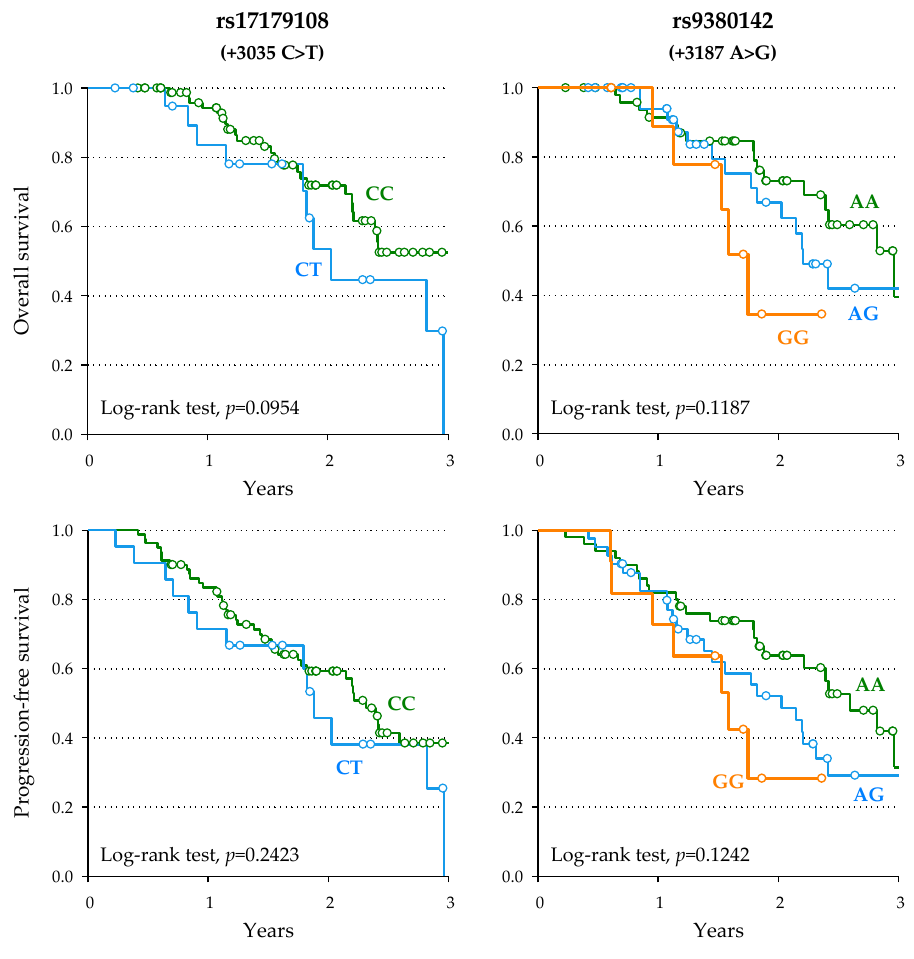
Figure 3. Kaplan – Meier estimate of overall survival and progression-free survival according to polymorphisms +3035 C > T and +3187 A > G. For polymorphism +3035 C > T (rs17179108), only one patient has the TT genotype; therefore, the survival curve is not shown.